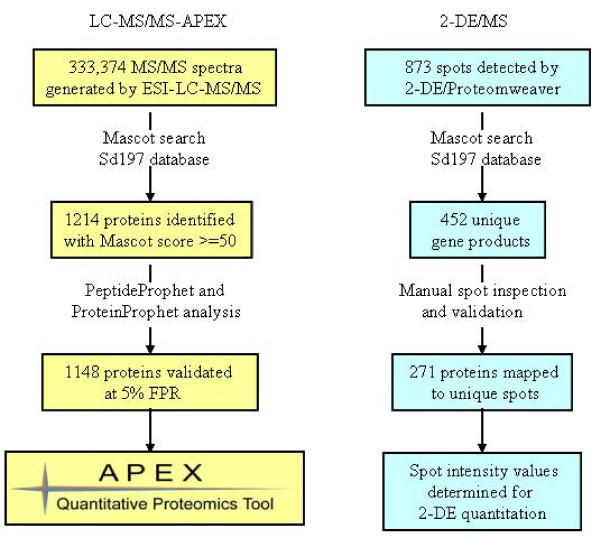
Flow chart of data analysis approach. The data analysis approaches employed for the LC-MS/MS-APEX and 2-DE/MS methodologies are shown here. The numbers in both approaches represent the average of three replicate experiments. 1148 SD1 proteins were quantitated by LC-MS/MS-APEX and 271 proteins from 2D gels.